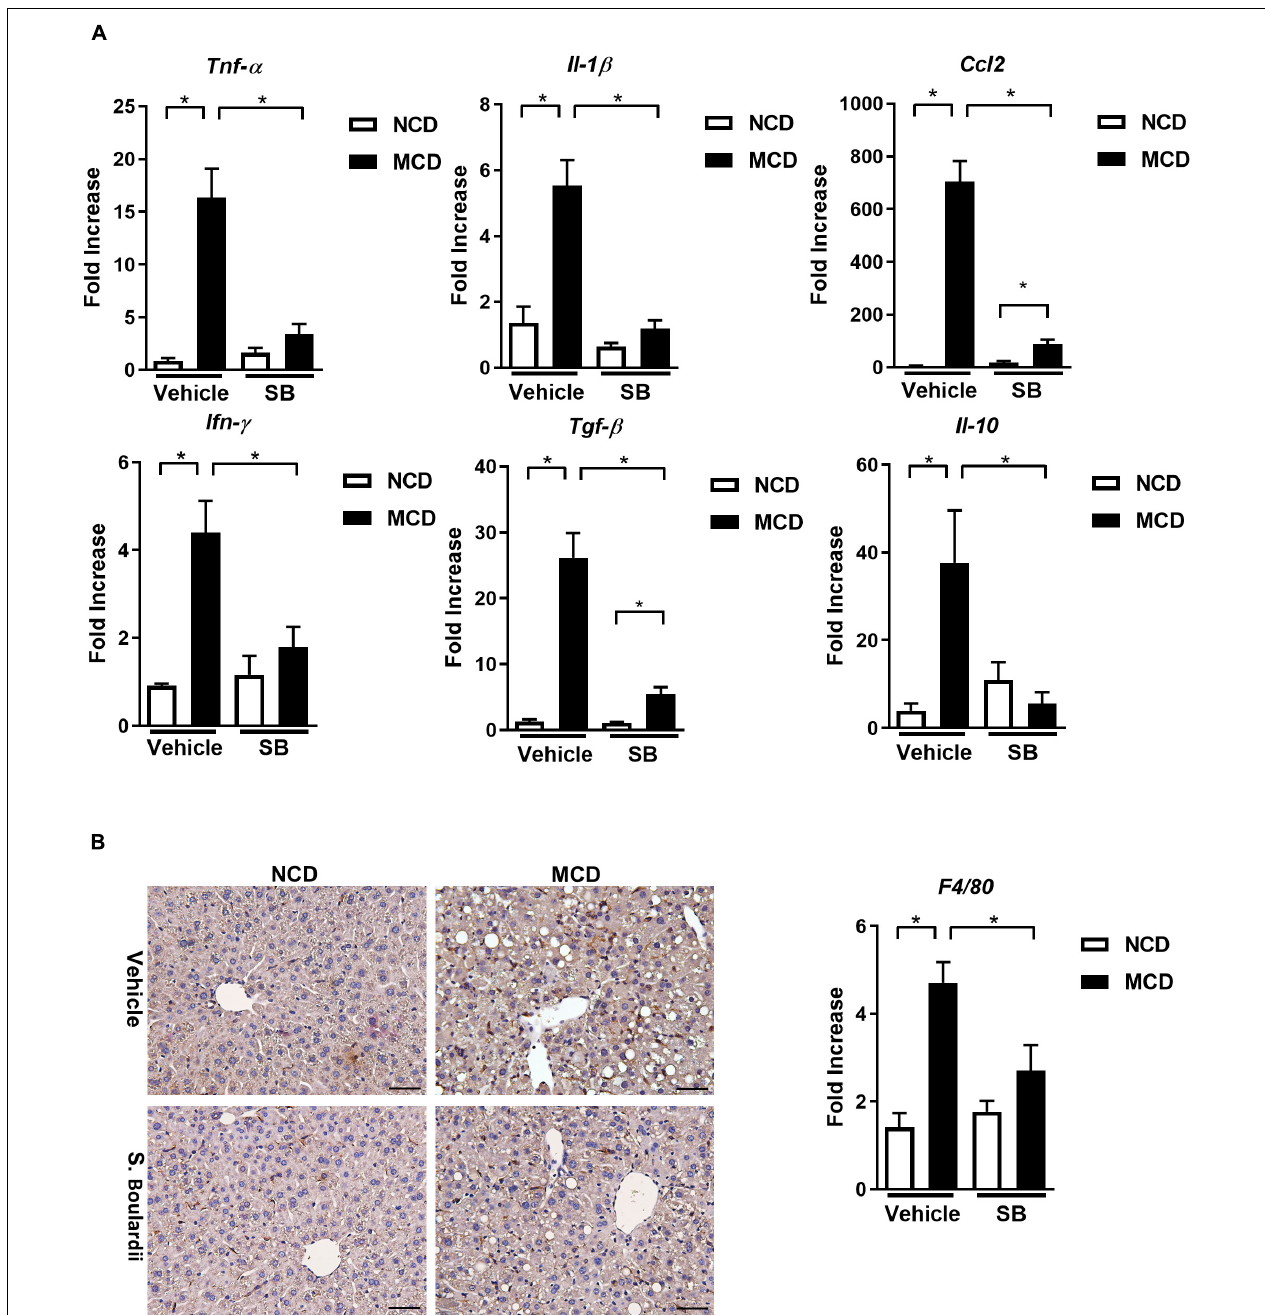
FIGURE 2 | Hepatic inflammatory responses caused by the MCD diet were suppressed by SB gavage. (A) Hepatic expressions of proinflammatory cytokines. (B) Representative liver sections of immunohistochemical staining of F4/80 and hepatic expression of F4/80. Scale bars: 50 µ m. * p <